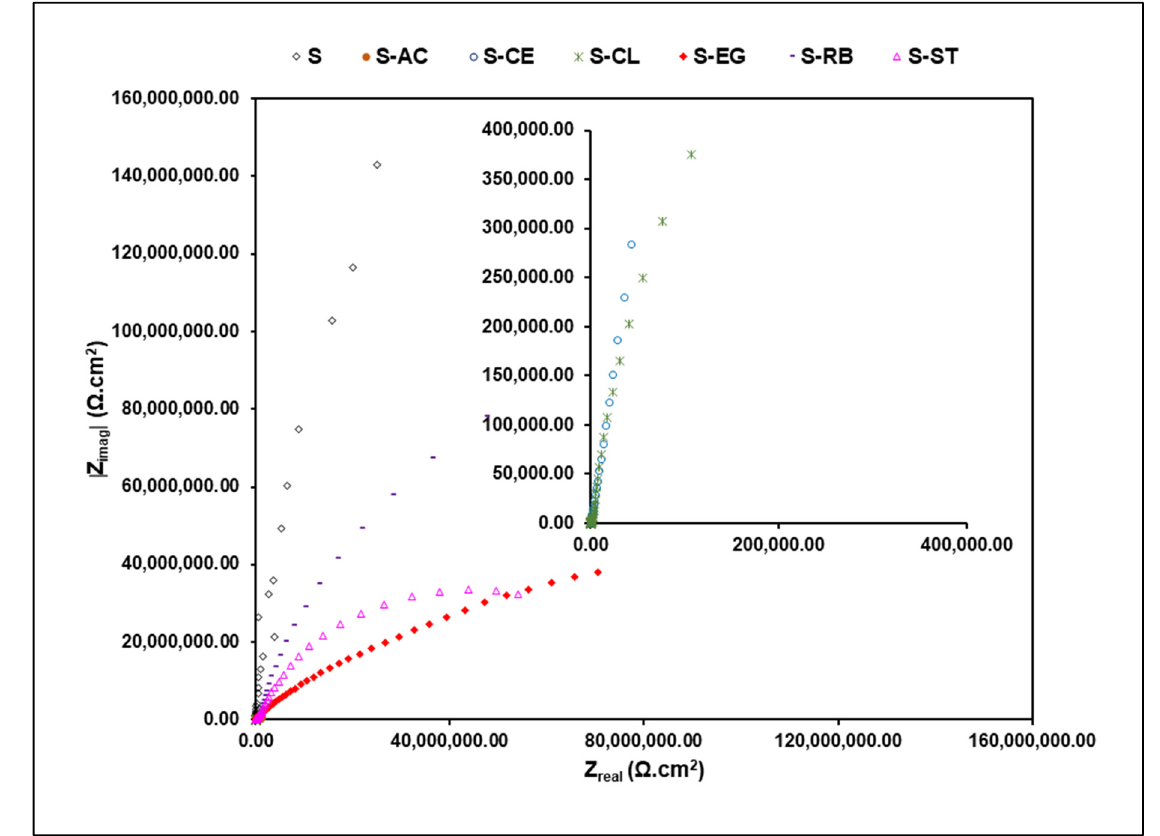
Figure 8. EIS Nyquist spectra of all coated samples on AA3003 substrate after 30 days of exposure to the 3.5 wt.% NaCl solution.